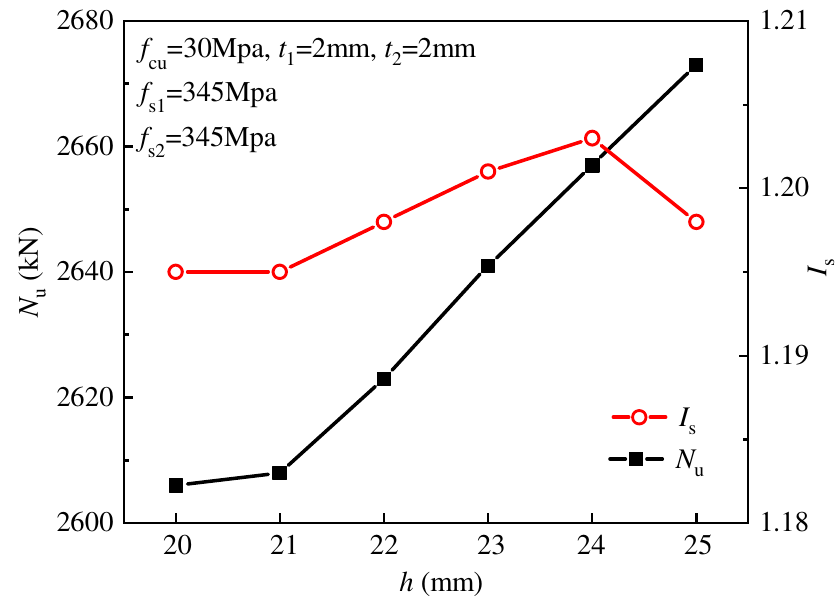
Figure 15. Influence of wave height of corrugated steel plate on N u and I s . Table 3. Specific parameters and results of models.